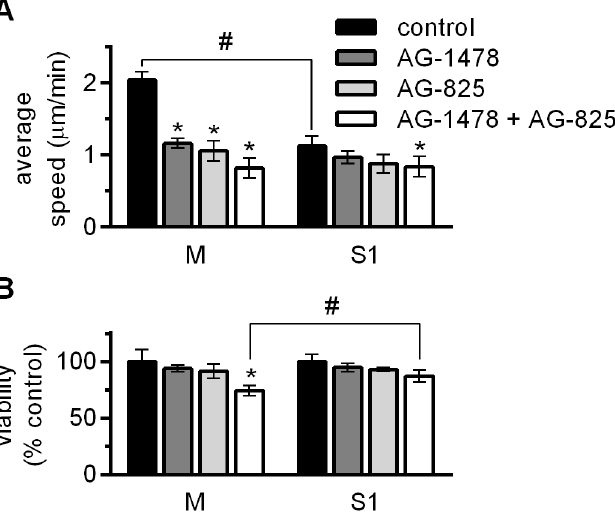
Fig 5. Effect of inhibitors of EGFR family receptors on lymphatic endothelial cells (LEC) motility and viability. ( A ) Analysis of single cell motility. Bars represent average speed ± SD from two independent experiments of migrating M and S1 incubated in the basal medium (control) or in the basal medium supplemented with AG-1478 (inhibitor of EGFR, 1.5 μ M), or with AG-825 (inhibitor of HER2, 1 nM), or with the combination of AG-1478 + AG-825. In each experiment, movements of 30 cells per group were analyzed. * P < 0.05 vs control M or control S1 respectively; # P < 0.01 vs control M. ( B ) Viability of LEC incubated for 24 h in the basal medium alone (control) or in the basal medium supplemented with 1.5 μ M AG-1478, or with 1 nM AG-825, or with the combination of AG-1478 + AG-825, assessed by alamarBlue assay. Fluorescence intensity of control M or control S1, respectively, was taken as 100%. Bars represent average values ± SD from six independent experiments performed in sextuplicates. * P < 0.05 vs control M; # P < 0.05 vs M exposed to both